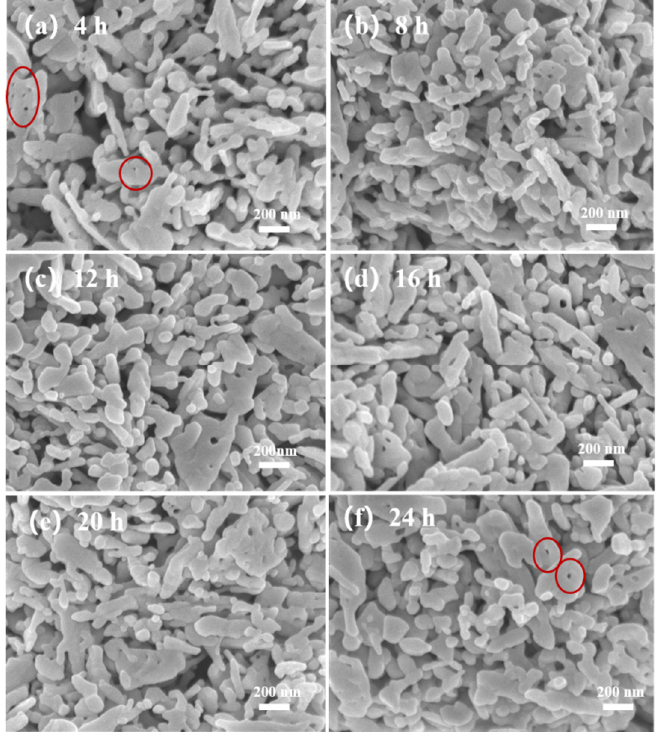
Figure 5. SEM of ZnO@ZIF-8 gas sensors after different growth times: ( a ) 4 h; ( b ) 8 h; ( c ) 12 h; ( d ) 16 h; ( e ) 20 h; and ( f ) 24 h.